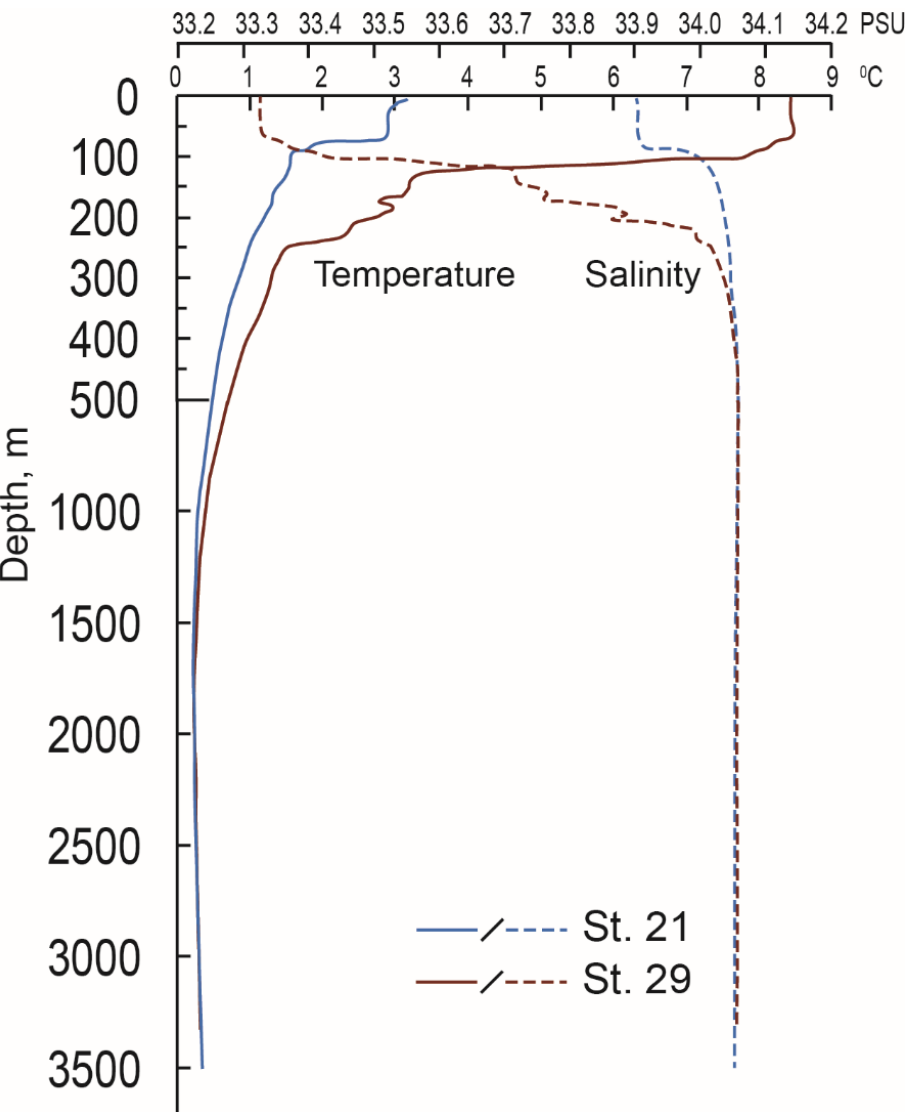
Figure 2. Salinity (PSU) and temperature (°C) vertical profiles at the sampling stations in the Japan Basin.